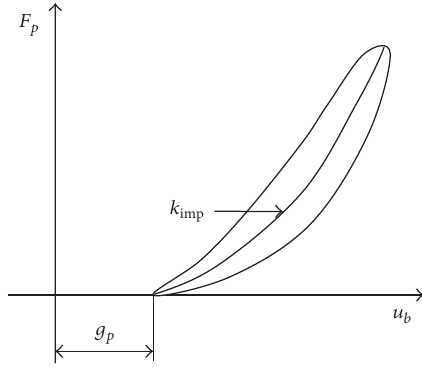
Figure 1: Hertz-damp pounding